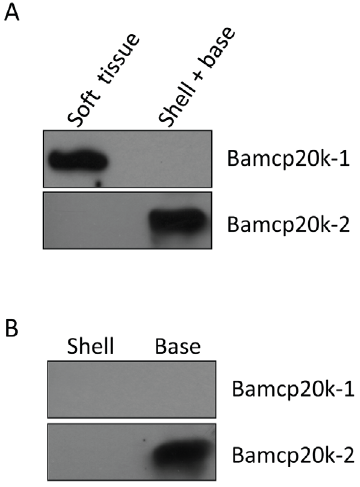
Figure 6. Bamcp20k-2 was enriched in the basal plate. (A) An adult barnacle was divided into two portions: the soft tissue and the shell with base. These two portions were extracted in urea buffer. Equal proportions from each fraction were collected for Western blot against Bamcp20k-1 and Bamcp20k-2. (B) Equal amounts of extract (60 m g) from shell and base were collected and blotted with the antibodies against Bamcp20k-1 and cp20k-2. Fr: fraction.